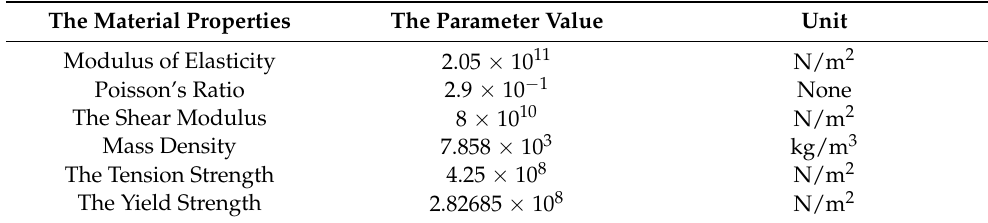
Table 1. 1023 Carbon steel material attribute table.